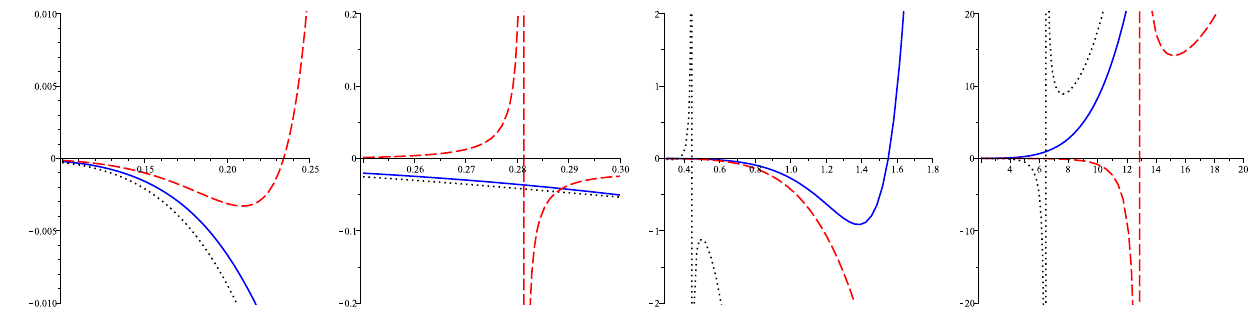
Fig. 13 C P , X versus r + for k = 0, d = 7, q = 1, α = 1, P = 1 / 8 π , m = 0 . 1, c 1 = c 2 = c 3 = c 4 = 1 and c 0 = 1 (solid line), c 0 = 5 (dotted i line) and c 0 = 10 (dashed line). Different scales: first panel (0 < r + < 0 . 25), second panel (0 . 24 < r + < 0 . 3), third panel (0 . 3 < r + < 1 . 8) and fourth panel (1 . 8 < r + < 20)